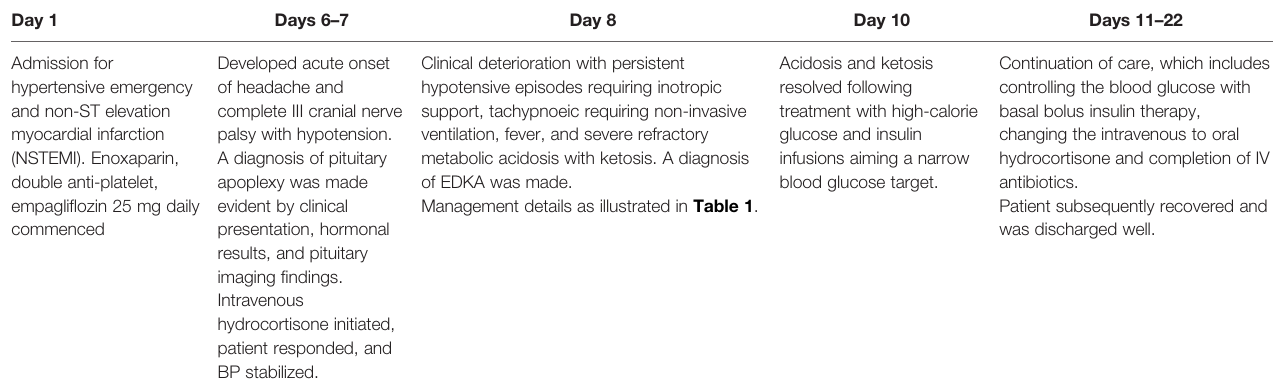
TABLE 2 | Chronology of events from admission.